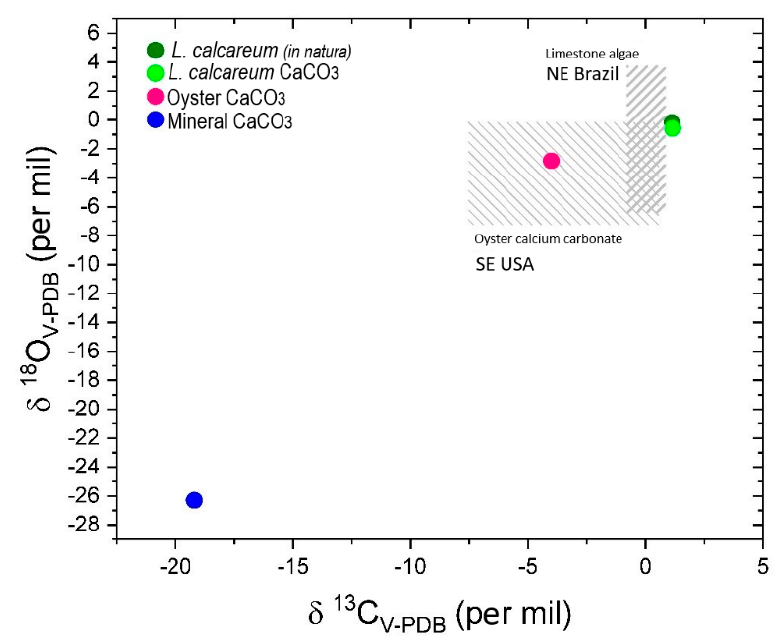
Figure 10. Stable isotopes of carbon ( δ 13 C) and oxygen ( δ 18 O) in the analysed carbonates in reference to the V-PDB standard (Vienna Pee Dee Belemnite international standard) [59]. The hatches indicate the field of isotopic composition of carbonate algae from Northeastern Brazil [60] and oyster shell CaCO 3 from the south-eastern coast of the U.S. [61].